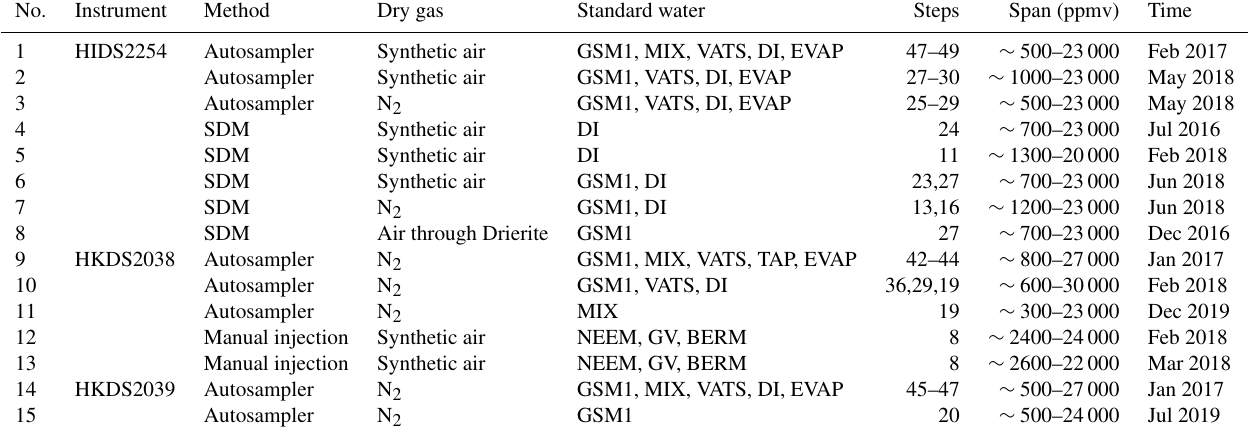
Table 1. Overview of all 14 characterisation experiments regarding the instrument, the vapour-generation method, the type of dry gas supply, the measured standard waters, the mixing ratio steps, the mixing ratio span, and the experiment time. For characterisations with injections, four injections are typically carried out at each mixing ratio. For characterisations with continuous vapour streaming via a Standard Delivery Module (SDM), normally 20–40min of measurements are carried out at each mixing ratio. The values of the water concentrations are the uncalibrated values measured on the corresponding analyser. Instrument HIDS2254 is model type L2130-i, while instruments HKDS2038 and HKDS2039 are of model type